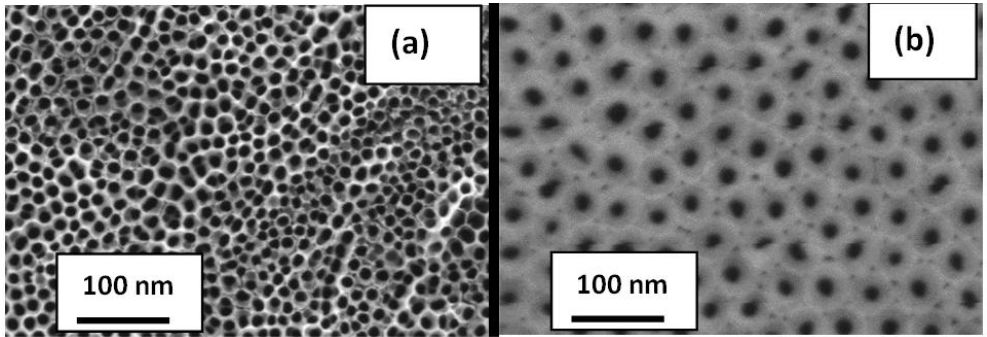
Figure 4. SEM micrographs displaying the diameter change along the layer thickness from top ( a ) to bottom ( b ) of the TiO NTs synthesized by anodization of Ti in EG-based solutions. 2